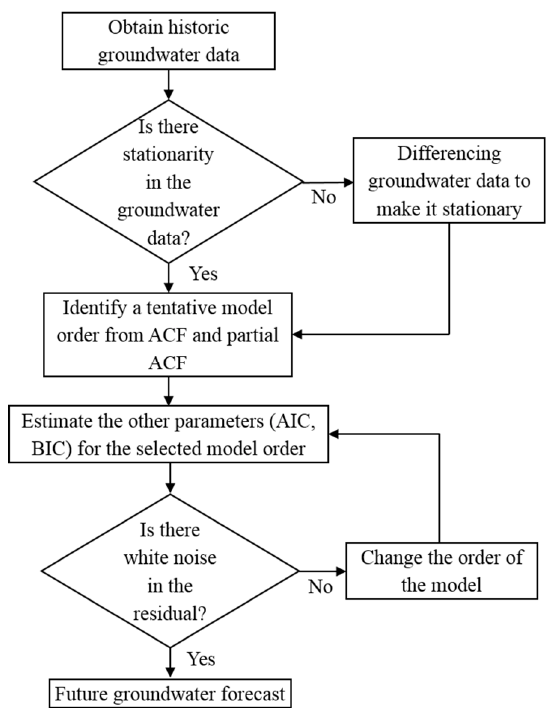
Figure 2. Autoregressive Integrated Moving Average (ARIMA) modeling framework to forecast groundwater anomaly. AIC: Akaike Information Criterion; BIC: Bayesian Information Criterion; ACF: autocorrelation function.